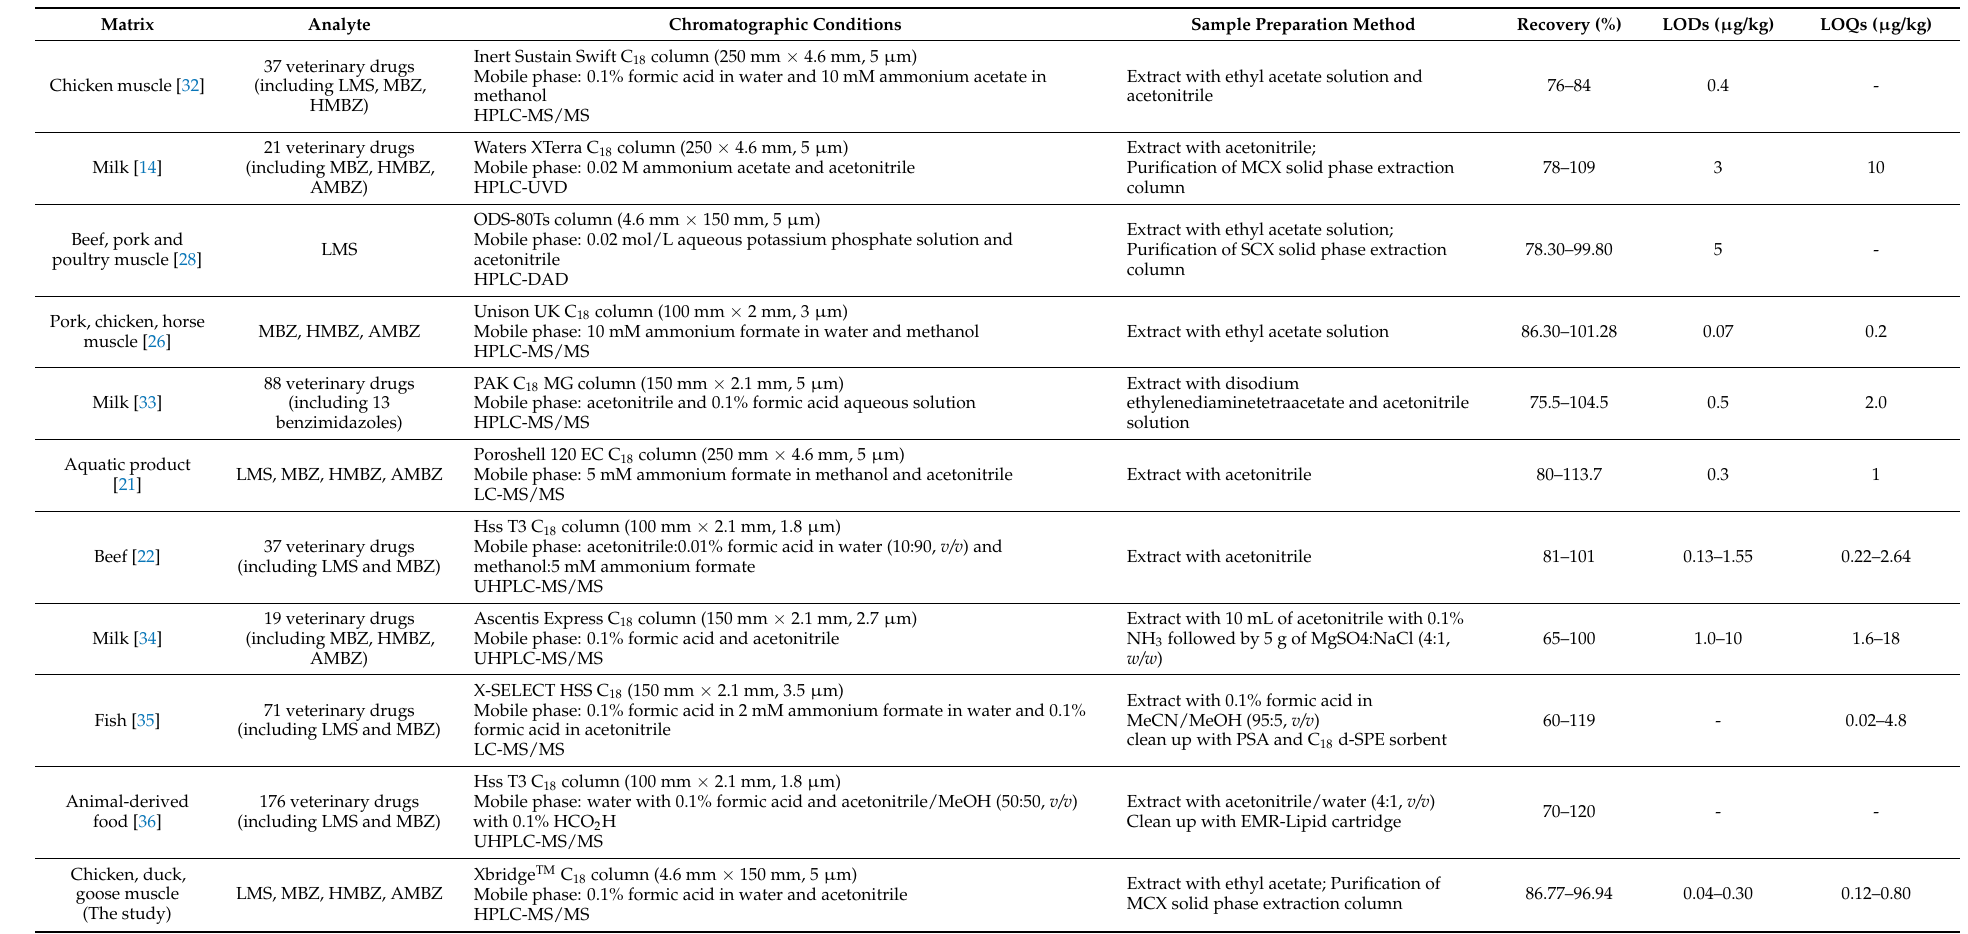
Table 7. Comparison of detection results between this research method and other LC